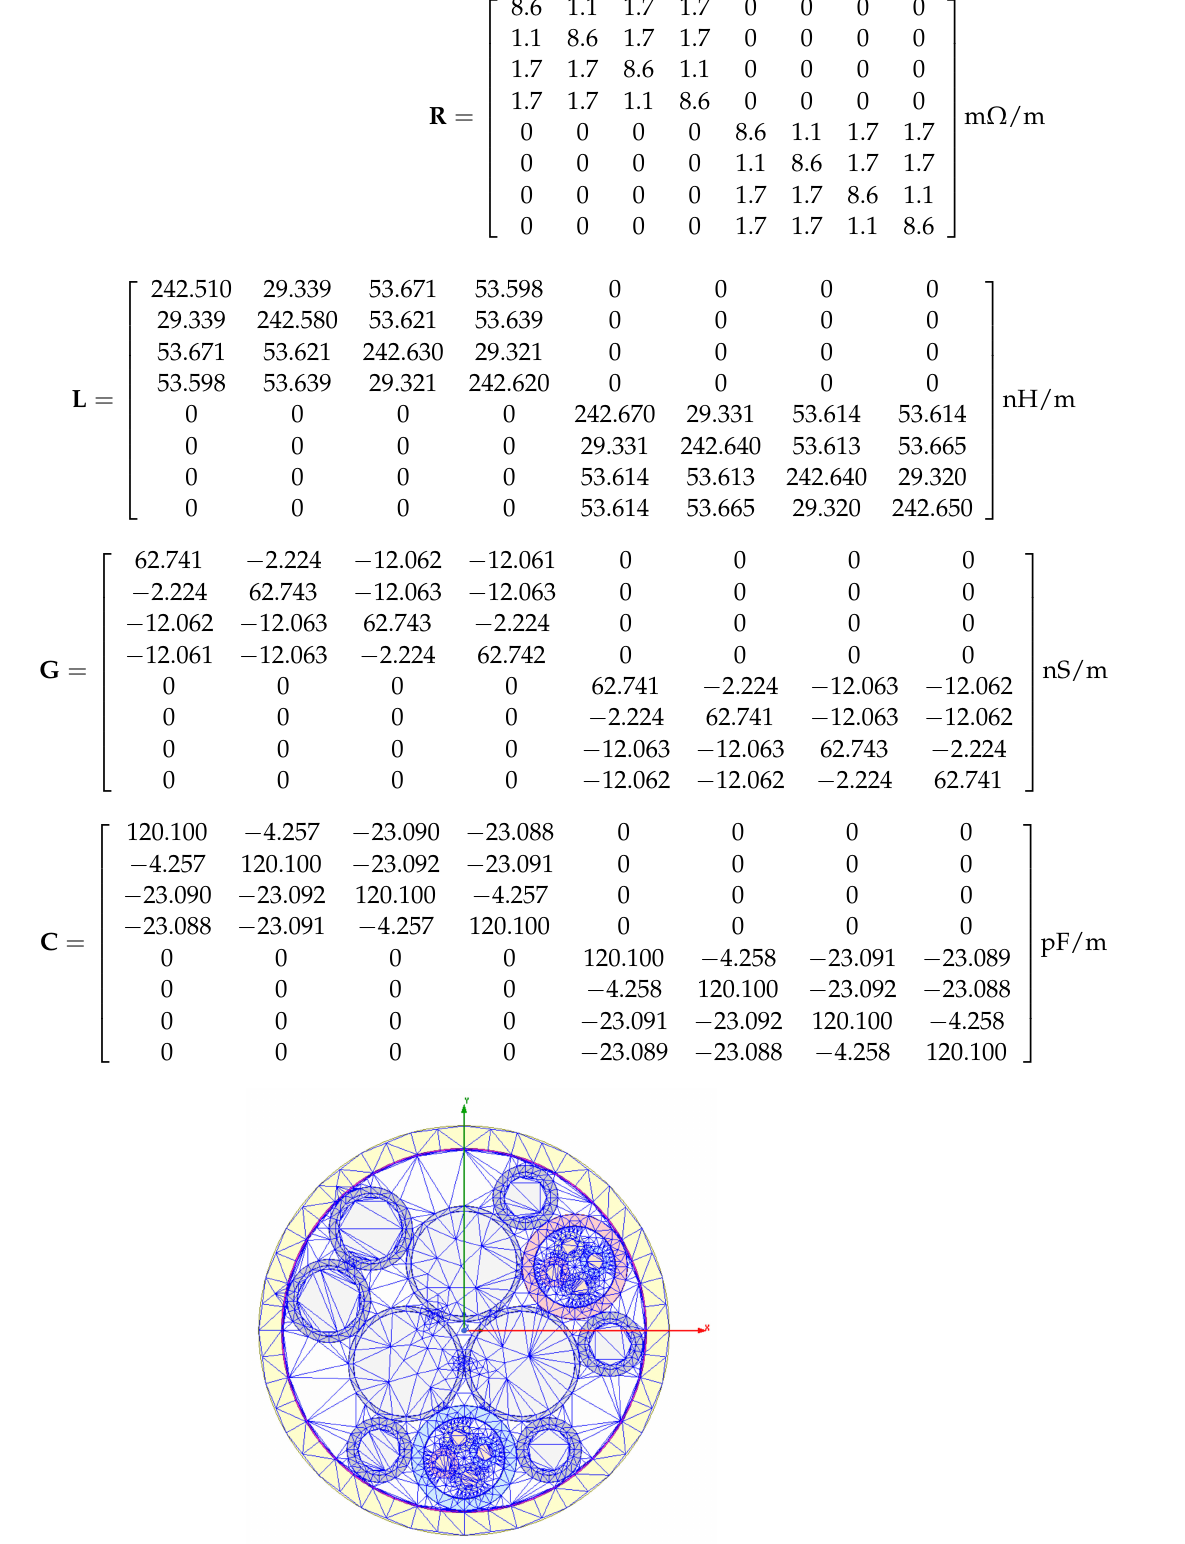
Figure 7. Finite element mesh of the cross section of the umbilical